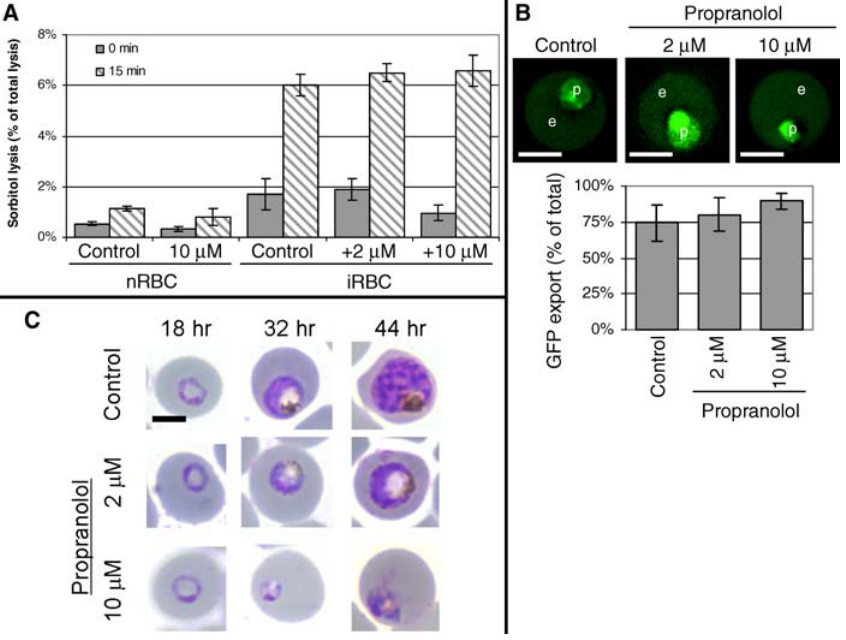
Figure 6. Analysis of the Maturation Defect in Propranolol-Treated Parasites (A) Effect of propranolol on sorbitol sensitivity of infected erythrocytes. Normal or infected erythrocytes were mock-treated or incubated with 2 or 10 l M propranolol for 30 h and then resuspended in 5% sorbitol as described in Methods. Bars represent percentage lysis as calculated by the hemoglobin absorbance (570 nm) of the supernatant after 0 and 15 min of sorbitol treatment divided by the hemoglobin absorbance of a saponin-treated sample (where 100% of hemoglobin is released) from the same culture. Error bars show the standard deviation from triplicate samples. (B) Effect of propranolol on export of a parasite-encoded protein (PfHRPII) fused to GFP to the host erythrocyte. Fluorescence micrographs of infected erythrocytes that were mock-treated or exposed to 2 or 10 l M propranolol for 30 h (see Methods) are shown, with single optical sections. Bar represents 5 l m. The fraction of GFP exported to the erythrocyte (e) from the parasite (p) was determined (see Methods) and is relatively unchanged by drug treatment. Error bars show the standard deviation from ten samples per treatment. (C) Giemsa-stained thin blood smears showing the morphology of parasites when infected erythrocytes were treated with 2 or 10 l M propranolol for 15, 32, and 44 h of culture. Infected erythrocytes treated with 2 l M propranolol showed significant retardation in schizont formation by 44 h. At 10 l M propranolol, a growth defect was observed by 32 h post-invasion. Bar represents 3 l m; all images are displayed at the same scale. doi:10.1371/journal.pmed.0030528.g006 (Figure 7A and Table S1; the 3:1 and 1:1 propranolol:chlor- oquine combinations had 11- and 4-fold effects, respectively).